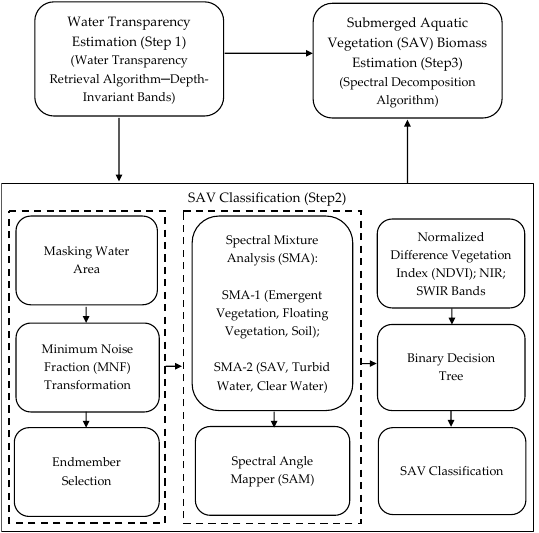
Figure 4. Methodology flowchart indicating the contribution of each step (steps 1 and 2) in SAV biomass estimation (step3).